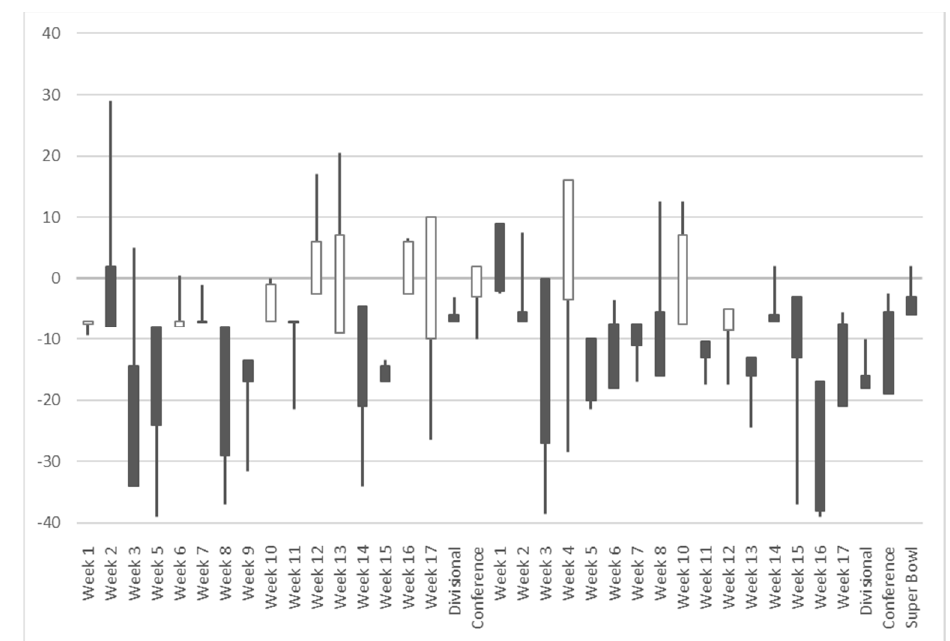
Figure 2. Candlestick chart of New England in 2015/2016 and 2016/2017.